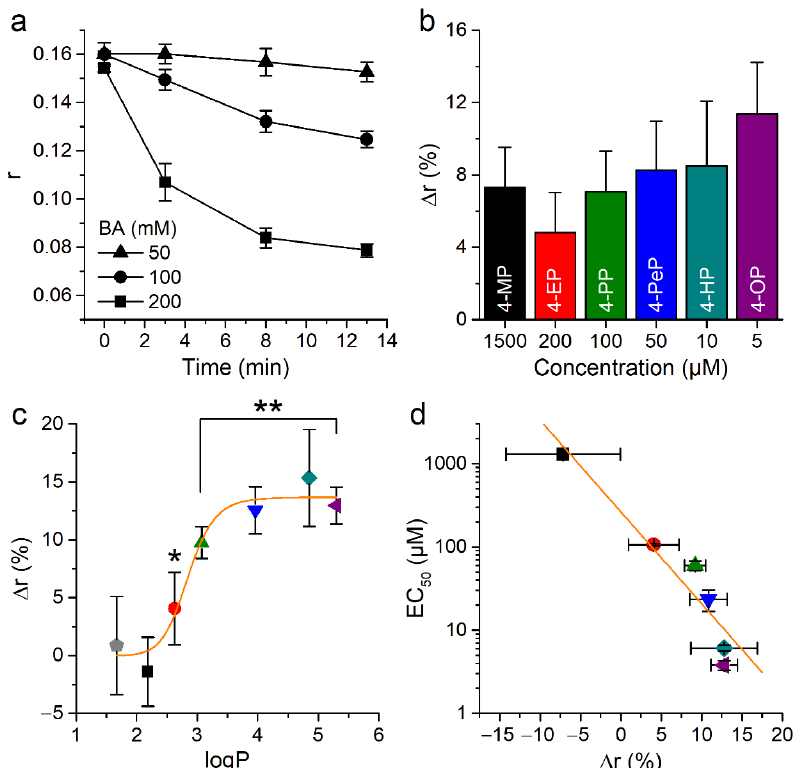
Figure 8. Effect of alkylphenols on the anisotropy of 1,6-diphenyl-1,3,5-hexatriene (DPH) fluorescence. ( a ) Time course of anisotropy changes induced by application of 50, 100, or 200 mM of BA. ( b ) Change in anisotropy (after 3 min pre-treatment) caused by near to EC 50 for mTRPA1 concentrations of APs. All experiments were conducted in CHO-mTRPA1 cells stained with 10 µM DPH and measured at T = 37 °C using FlexStation III. The data is shown as mean ± s.e.m. from at least three experiments. ( c ) Relationship between changes in membrane fluidity induced by the phenol and its derivatives (all at 10 µM) and the calculated partition coefficient of these compounds. (* p < 0.05, ** p < 0.01, two-tailed Mann-Whitney U test). The orange line represents the fit with a Hill function with maximal amplitude 13.7 ± 0.9, midpoint 2.85 ± 0.09, and Hill coefficient 13 ± 5. ( d ) Relation between EC 50 value and change in anisotropy induced by AP application. The orange line represents the fit with a linear function with a slope of −0.11 ± 0.01 μM (Pearson’s correlation coefficient 0.98, R 2 = 0.96).